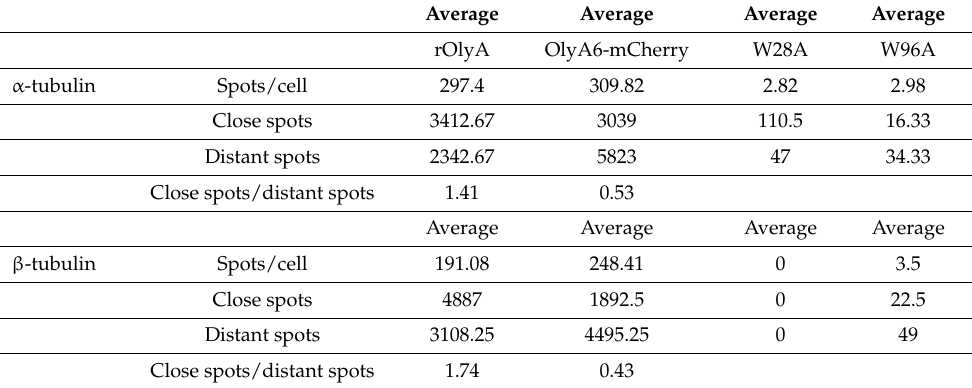
Table 1. Imaris analysis: protein interaction with α / β -tubulin filaments after 150 min of treatment. The ratio between close protein spots and distant protein spots was calculated to obtain the rate of OlyA-containing proteins and tubulin colocalization. Mutant W28A did not colocalize with α -tubulin filaments; W96A, with abolished cell-internalization ability, showed minimal colocalization with α -tubulin